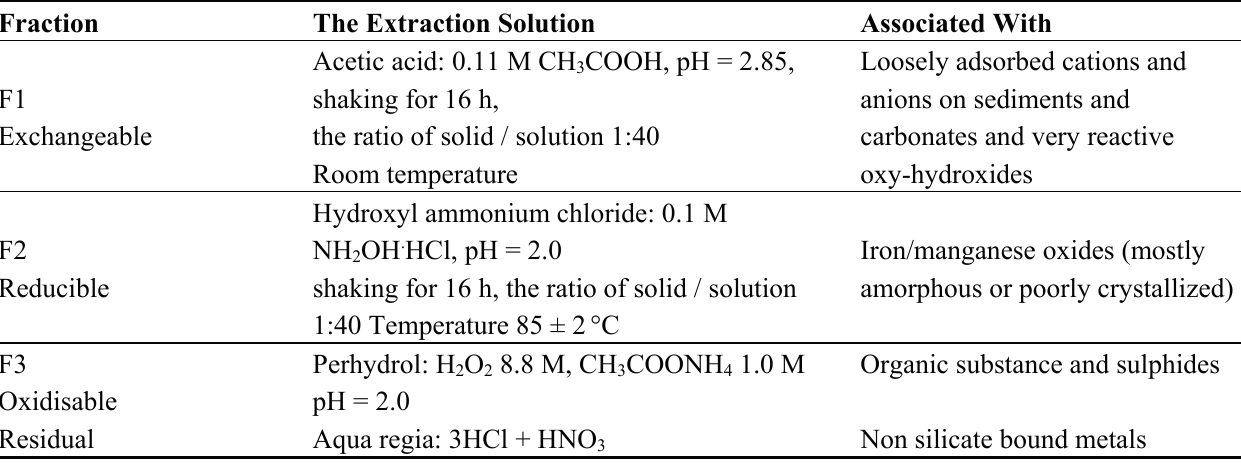
Table 2. BCR sequential chemical extraction procedure.